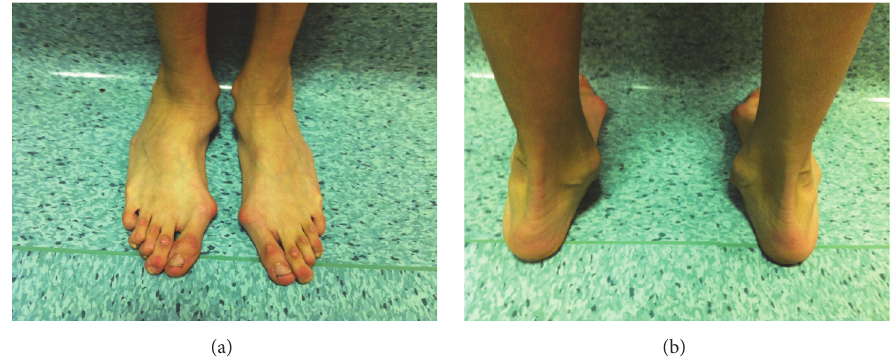
Figure 3: Hindfoot deformity with a marked valgus heel in a 23-year-old man affected by Marfan syndrome.